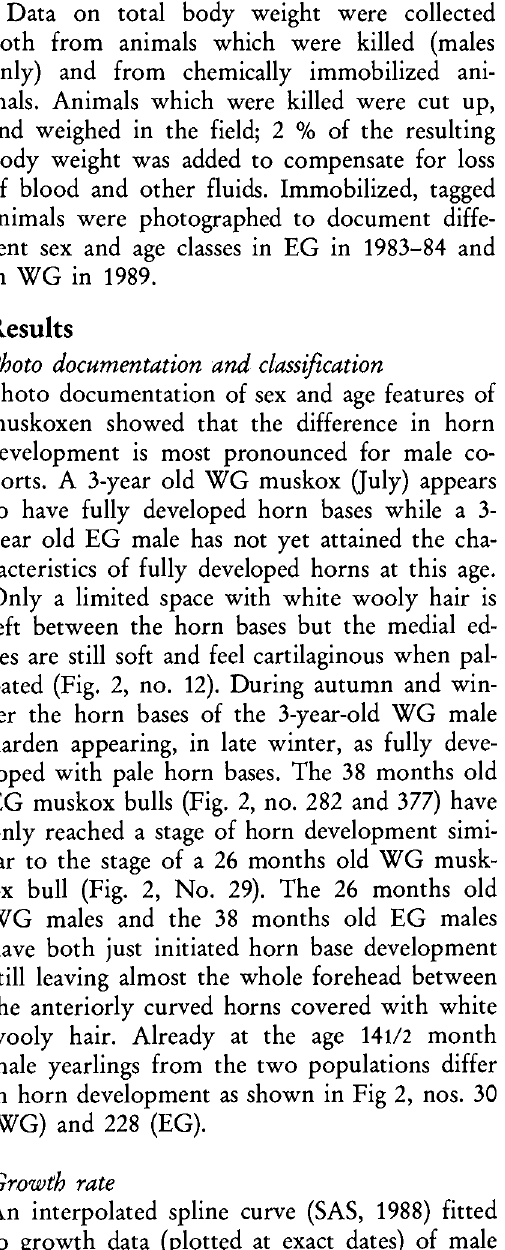
Fig. 1. Location of the two study areas in Greenland.